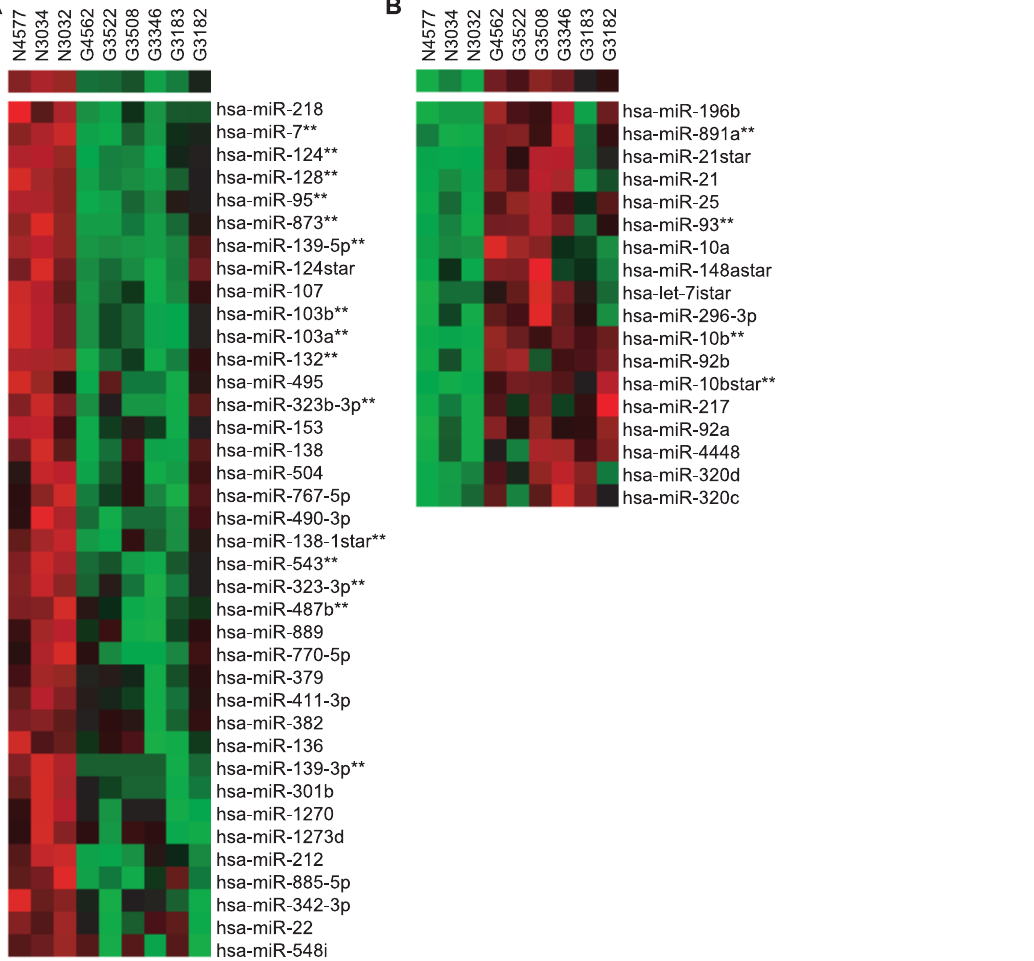
Figure 1. Differentially expressed miRNAs in glioblastomas versus non-tumor brain tissue. miRNA expression levels were determined by deep sequencing. Shown are heat maps for the 38 miRNAs most significantly down-regulated (A) and the 18 miRNAs most significantly up-regulated (B) in the six glioblastoma (G) samples compared to non-tumor brain tissue (N) (mean fold change . 4, p , 0.05 by t test). Highlighted are miRNAs that fulfill the FDR-adjusted selection criteria (** p , 0.1) as reported in Table S6. Two additional miRNAs, miR-let-7d and miR-598, also meet the FDR cut-off but exhibit a fold change , 4 and are not shown. Prior to hierarchical clustering, deep sequencing reads with RPKM values . 1 as determined by miRNAkey [32] were log-transformed, and standardized across all samples to a mean of 0 and standard deviation of 1. Clustering was performed using Pearson’s correlation (average linkage method) as the distance matrix.